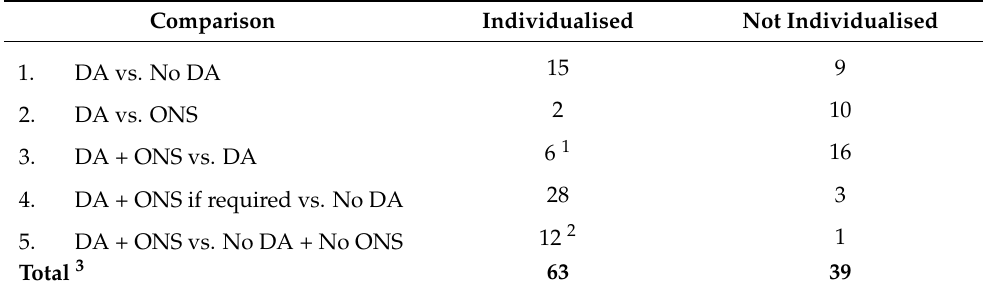
Table 3. Number of studies included by Baldwin et al. (2021) that describe individualised versus not-individualised nutritional care for management of disease-related malnutrition [5].